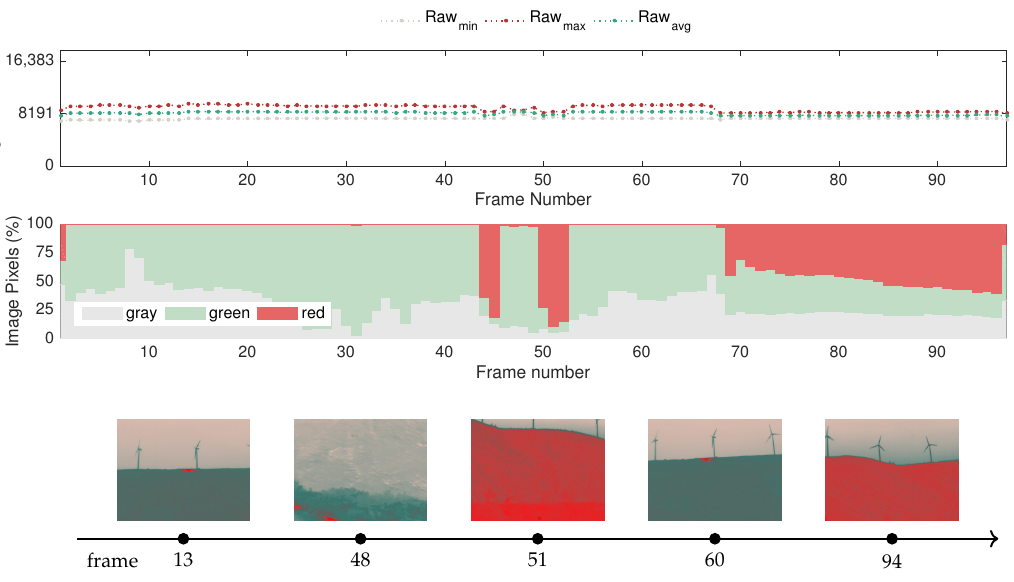
Figure 22. Results for the fire aftermath captured at long distance in a mountain range: raw features ( top ); color features ( center ); sample frames ( bottom